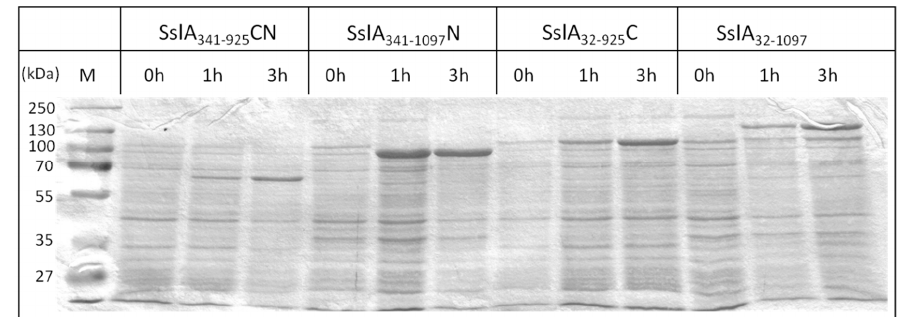
Figure 2. Heterologous expression of recombinant mature SslA and SslA truncation derivatives in E. coli. The Coomassie-stained protein gel shows expression of recombinant mature SslA 32-1097 , SslA 341-1097 N in BL21 (DE3) and SslA 341-925 CN, SslA 32-925 C in E. coli Rosetta Blue (DE3) whole